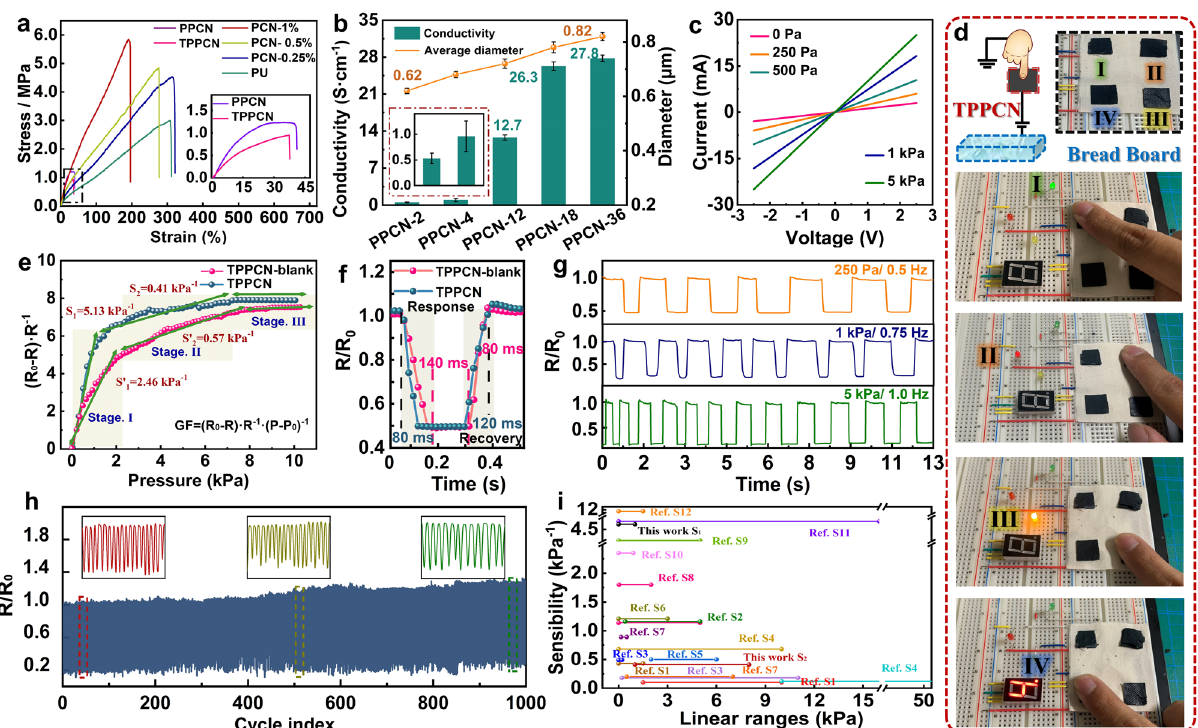
Fig. 3 Electromechanical properties of prepared nano fi brous membranes. a Typical tensile stress-strain curves of the prepared nano fi brous membrane. b Conductivity of PPCN membranes after in situ polymerization for different time. c I – V curves of the TPPCN membranes under different pressures. d Digital images of the touch sensors showing controlled lighting of LEDs through touching on the TPPCN membranes. e , f Comparison of the relative resistance change and response/recovery time of obtained TPPCN membrane with metal mesh template (TPPCN) and without special structure and morphology (TPPCN-blank) under an increased pressure. g Response of the TPPCN membrane with different pressure (0.25, 1.0 and 5.0 kPa) for various frequencies (0.5, 0.75, and 1.0 Hz). h 1000 loading/unloading process cycles toward the pressure variation from 0 to 500 Pa. i GF value of the TPPCN membrane compared with those reported in relevant literatures. The error bars presented in the plots represent the standard deviations of the respective